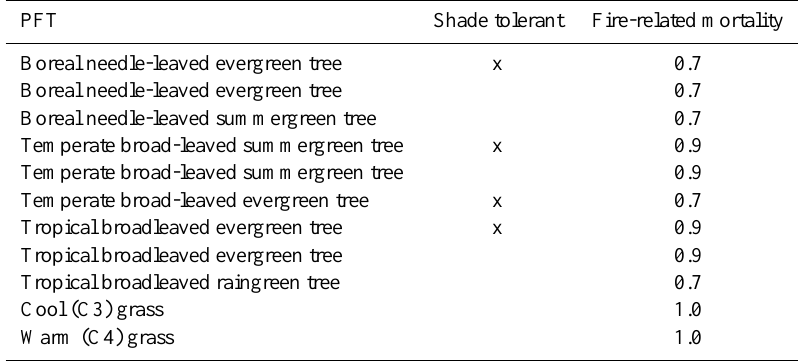
Table 1. Plant functional types and fire-related mortality used with LPJ-GUESS. PFT Shade tolerant